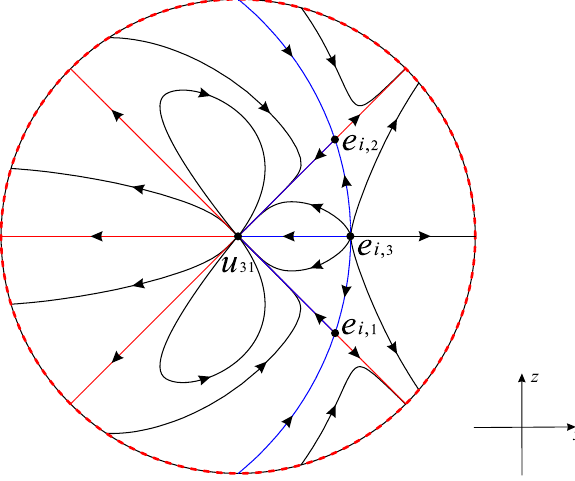
Fig. 6 The phase portrait of system (24), i.e., the phase portrait at infinity in the local chart U 3 of system (7)